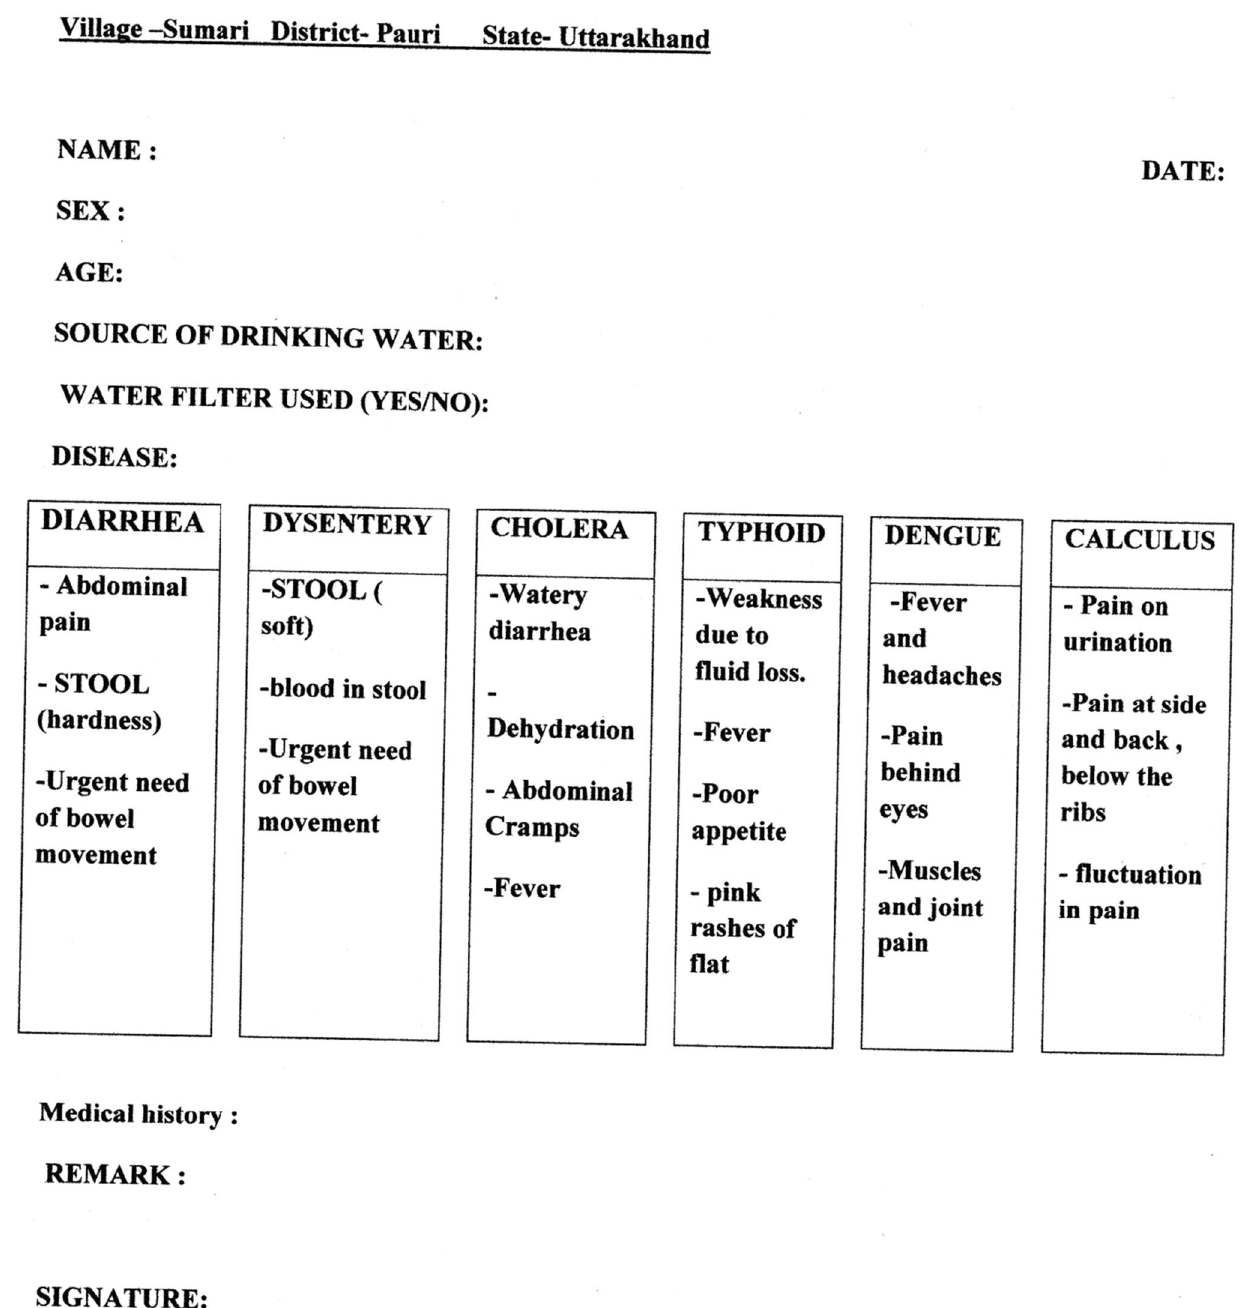
Fig. 2 Questionnaire used in